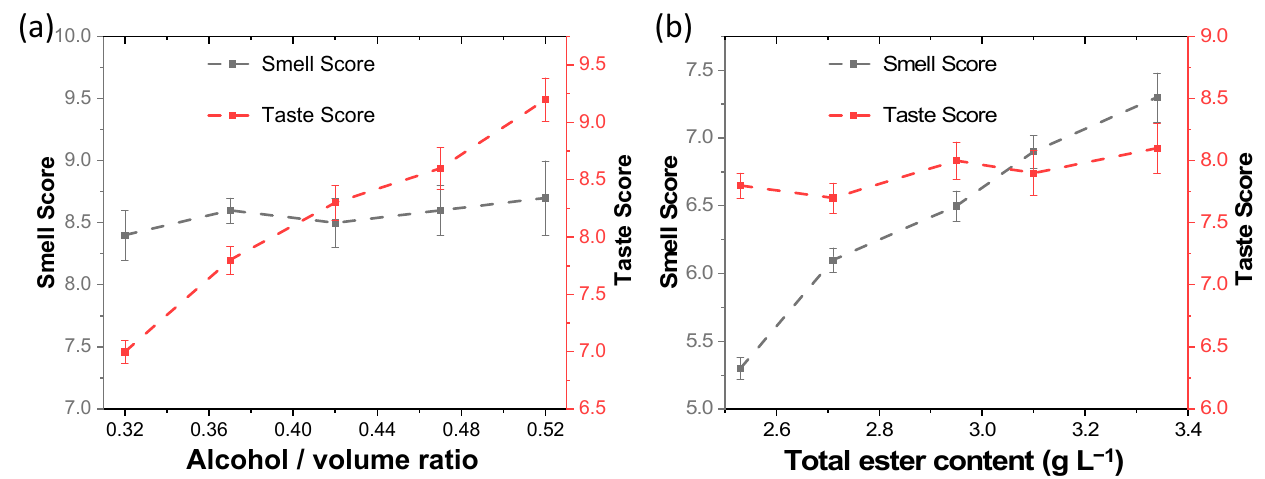
Figure 2. Sensory evaluation of model liquors with different alcohol ( a ) and ester ( b ) contents. Under certain conditions, the heat released or absorbed in the process of chemical reactions is called the enthalpy change of chemical reaction ( ∆ H ) [29]. The enthalpy change determines whether the reaction is exothermic or endothermic. The esterification process’s enthalpy change can be calculated according to the standard molar enthalpy of formation ( ∆ f H ). As shown in Table 1, ∆ H in the esterification process of ethyl butyrate and ethyl lactate is greater than 0 in the temperature range of 0 ◦ C–100 ◦ C, which is an exothermic reaction. According to the second law of thermodynamics [30], any chemical reaction in an isolated system always goes in the direction of increasing entropy ( S ). As shown in Table 1, compared with other esters, the S value of ethyl lactate increases the most. According to the change of H and S , the spontaneity of the reaction can be judged. Gibbs ( G ) energy is used to judge the spontaneity of the chemical reaction (Equation (1)) [31] to judge the reaction direction of the previously discussed esterification reactions under specific conditions.